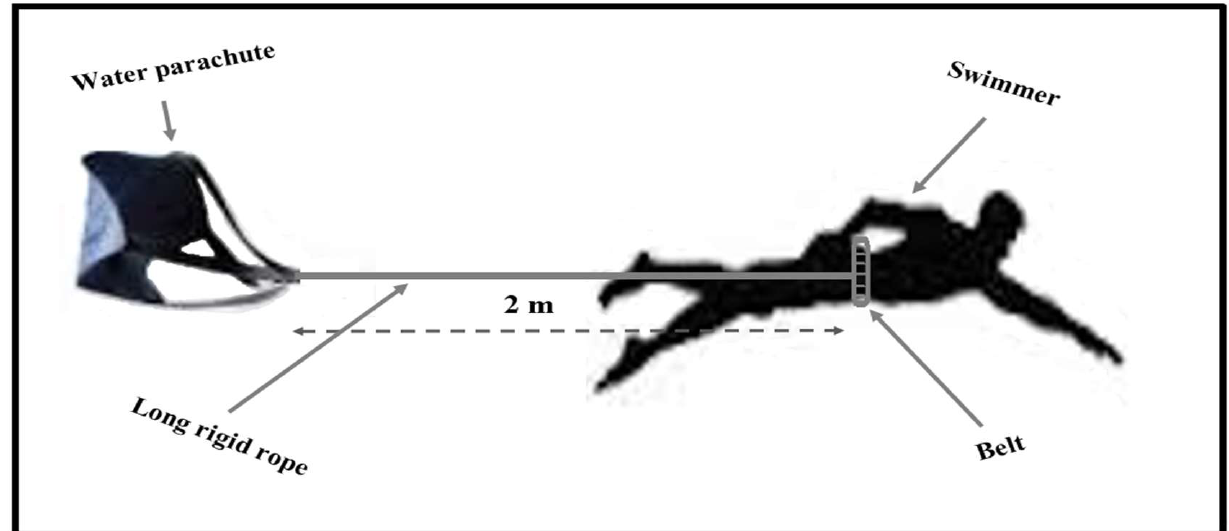
Figure 2. Set-up of water parachute during aquatic resistance training.